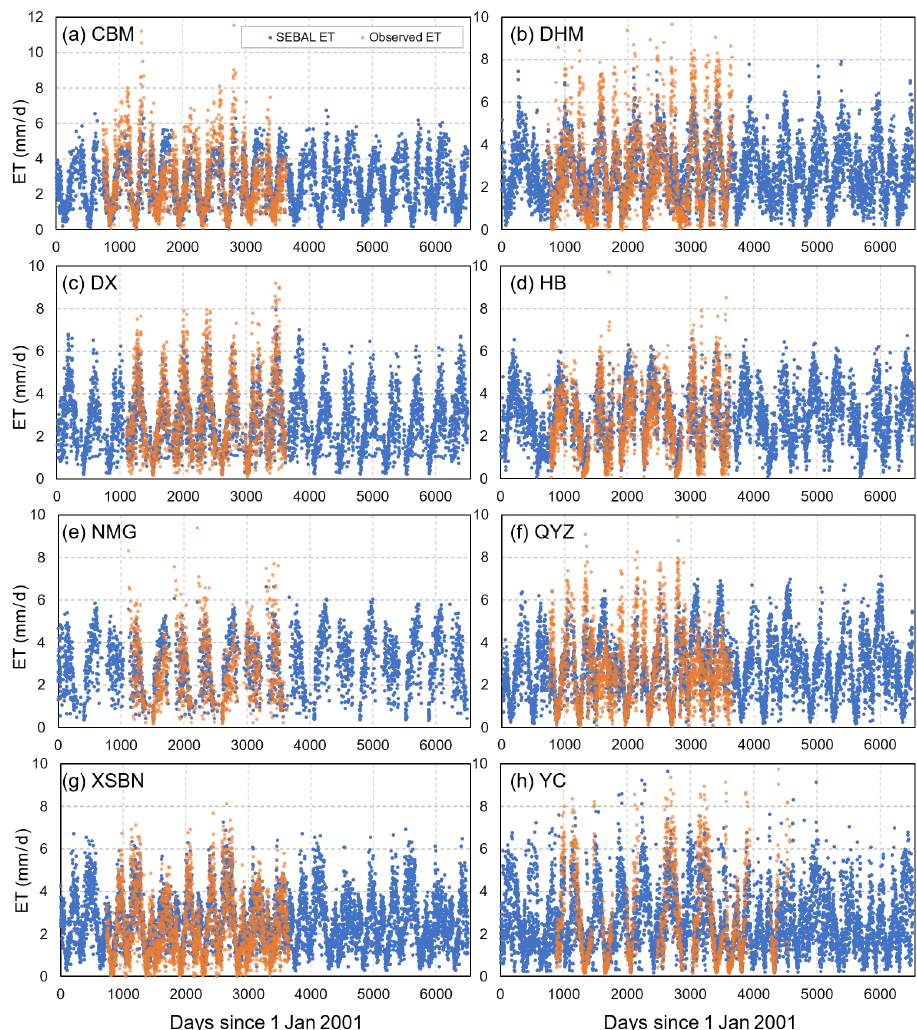
Figure 4. The SEBAL ET and flux-tower-observed ET variation in time series. (a) CBM; (b) DHM; (c) DX; (d) HB; (e) NMG; (f) QYZ; (g) XSBN; (h)